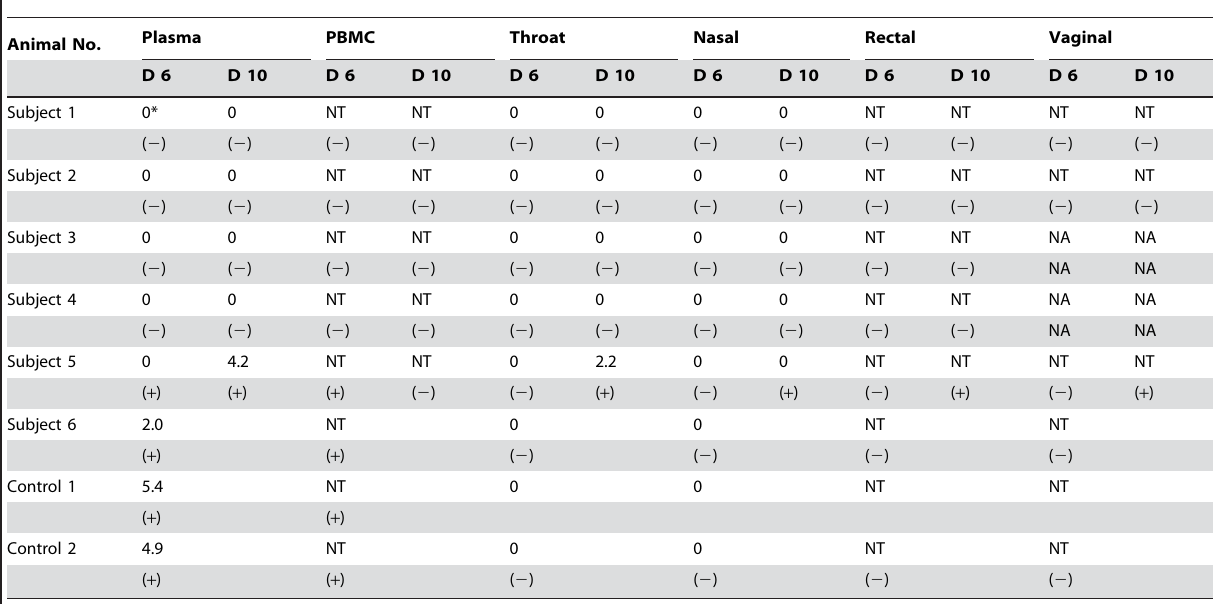
Table 4. Viral load in SHIV-infected rhesus monkeys after ZEBOV challenge.